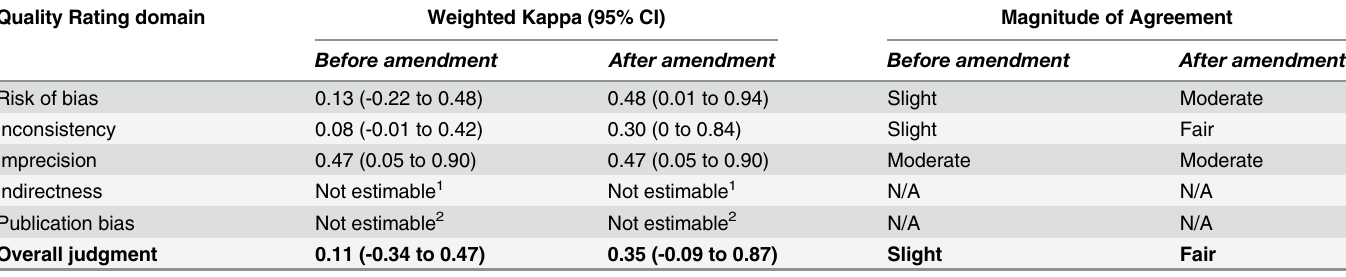
Table 2. Comparison of raters ’ judgments for one rater using SAQAT and one rater using the standard GRADE approach (before and after SAQAT amendment). Quality Rating